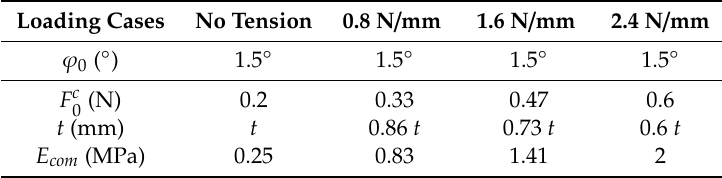
Table 2. Curve-fitting parameters for a carbon fiber plain-woven fabric.